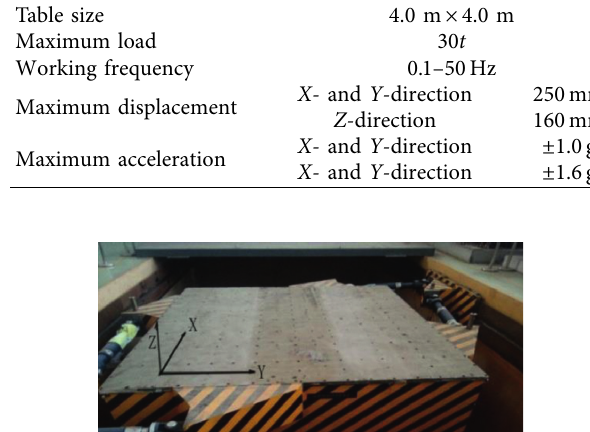
Table 1: Parameters of the shaking table. Table size